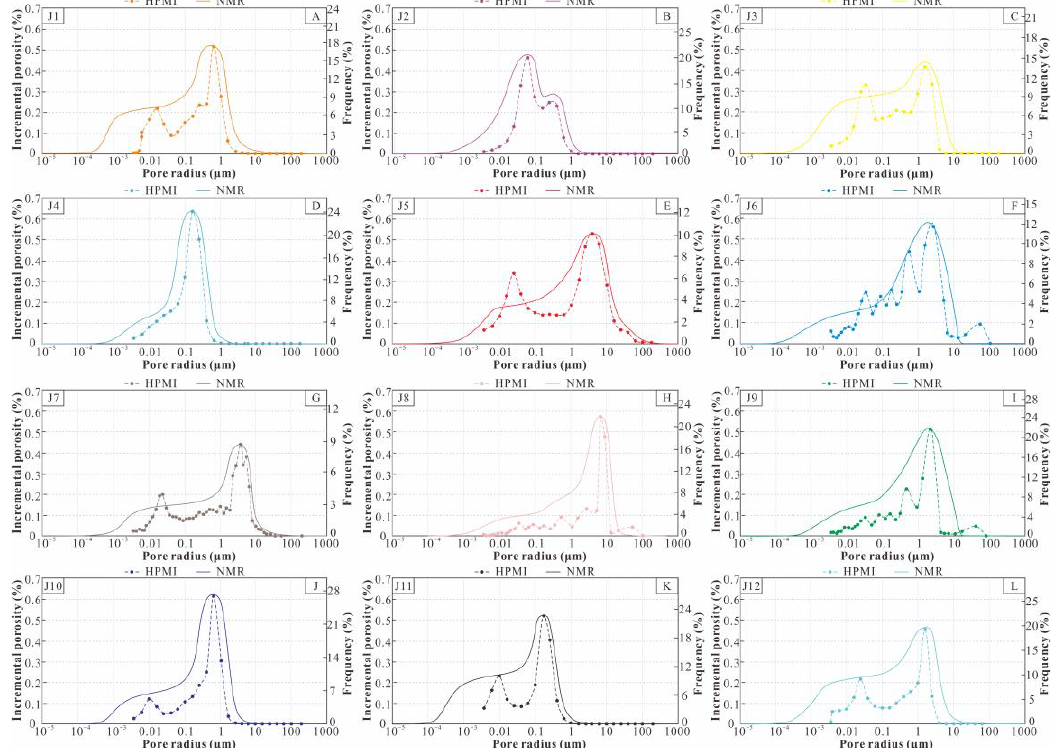
Figure 12. The fitting result between the NMR T 2 spectrum and pore-throat radius. Figures ( A – L ) correspond to samples JI to J12 respectively.